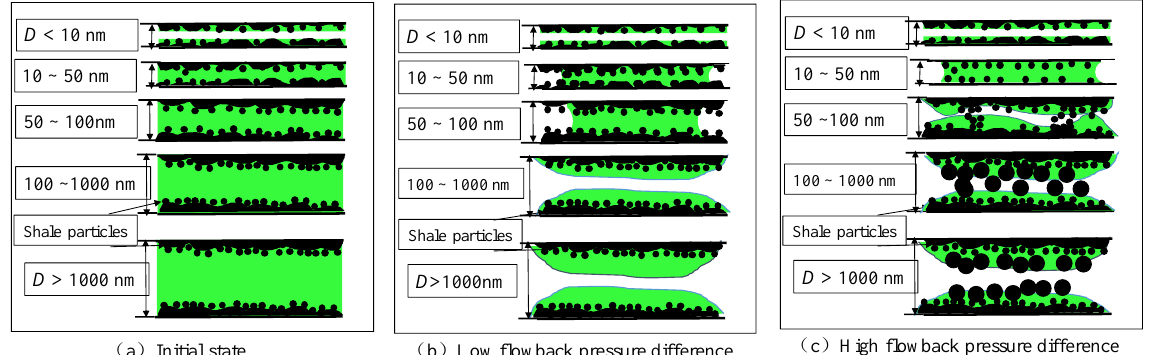
Figure 16. Schematic of water distribution and shale particle migration under low backflow pressure difference and high backflow pressure difference.